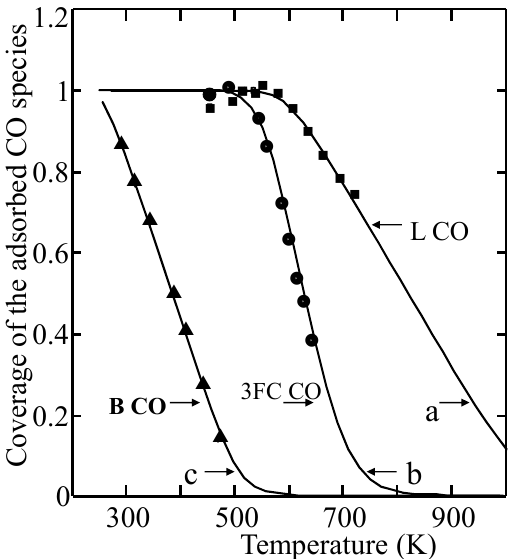
Figure 2. Comparison between experimental and theoretical curves θ X = f(T a ) at P a = 1 kPa for the different X CO species on 2% Pt/Al 2 O 3 : ■ , ● , and ▲ experimental data for the L, 3FC and B CO species respectively; (a), (b) and (c) theoretical curve according to Equations (4) and (5) for the L, 3FC and B CO species (see the text for the E 0 and E 1 values of each adsorbed species).